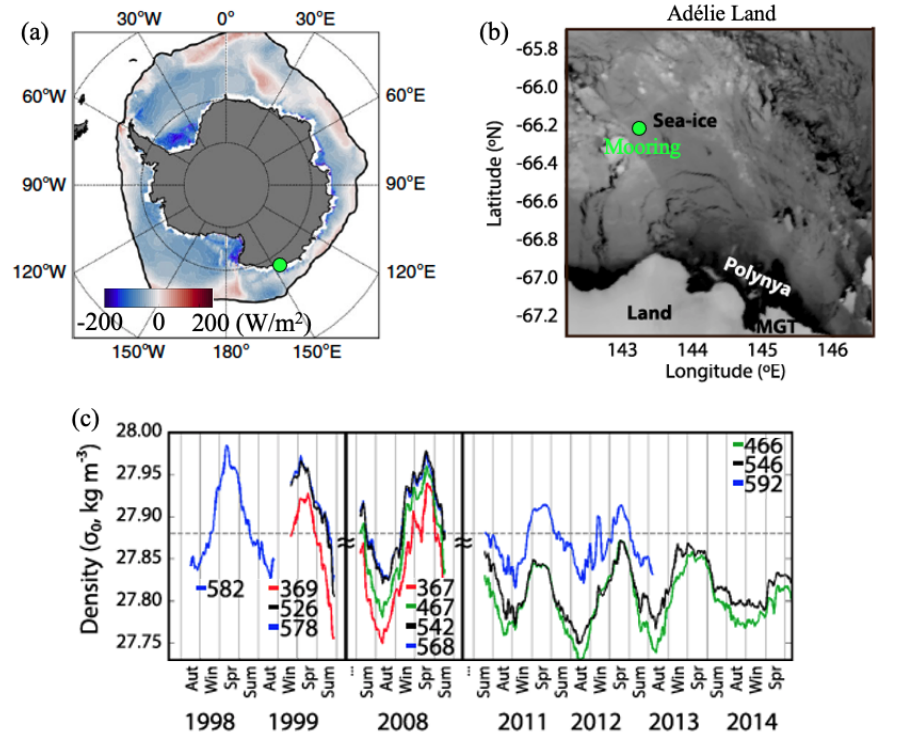
Figure 5. ( a ) The surface freshwater flux in the Southern Ocean for March–September (wintertime). Note that the wintertime surface buoyancy flux is dominated by the surface freshwater flux in this region. The sea-ice sector is the colored region partitioned to the north by the bold black line. The surface freshwater flux is shown here in units of equivalent W/m 2 (i.e., units of surface heat flux). The flux data are from analysis of ocean observations beneath sea-ice from ships, floats, drifters, and seal instruments [108,109]. Reproduced with permission from Pellichero et al. [109], published by Springer Nature 2018. The green dot shows the location of the Adélie Land observations in ( b , c ). ( b ) Satellite photograph of the coastal polynya and mooring position (green dot) off the coast of Adélie Land. ( c ) Mooring data of potential density of the water column at various depths (indicated by color, all depths are in meters). Both ( b , c ) are reproduced with permission from Snow et al. [95], published by John Wiley and Sons